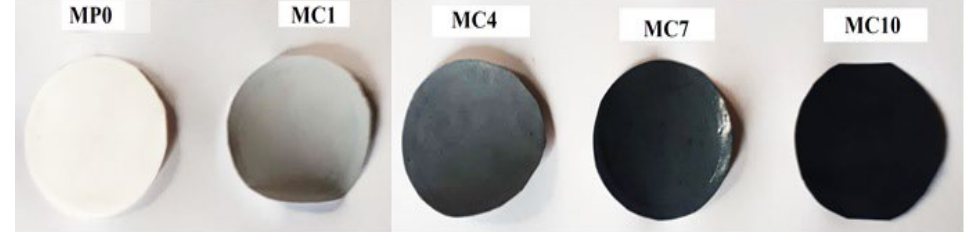
Figure 8. Fabricated pristine PES membrane and mAC incorporated PES membranes. Sample codes are summarized in Table 1.